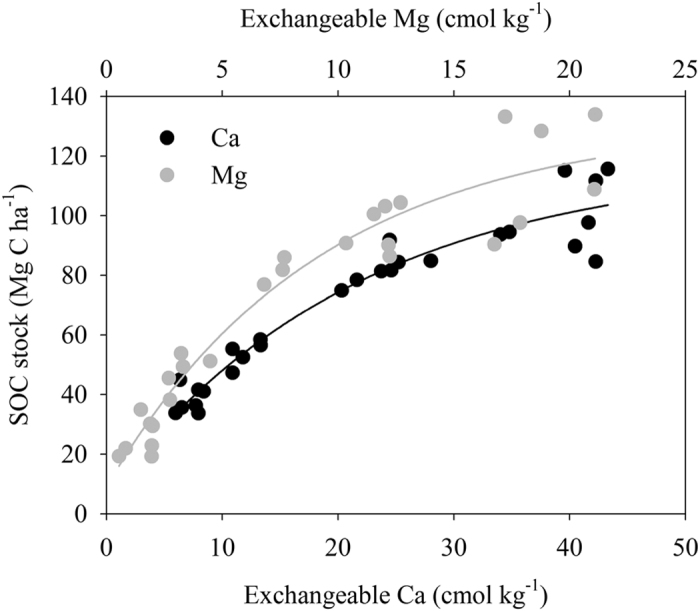
Relationship between SOC content and exchangeable Ca (y = 6.14 + 112.20(1 − exp(−0.05×), r2 = 0.93, p < 0.0001, n = 27) or Mg (y = 26.49 + 87.43(1 − exp(−0.11×), r2 = 0.93, p < 0.0001, n = 27).Each point denotes the mixture of 10 soil samples in a plot.